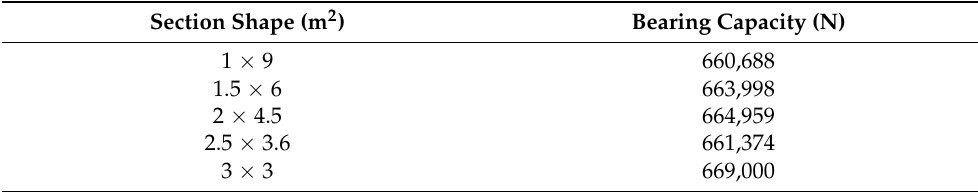
Table 4. Horizontal bearing capacity with different cross-sectional shapes.